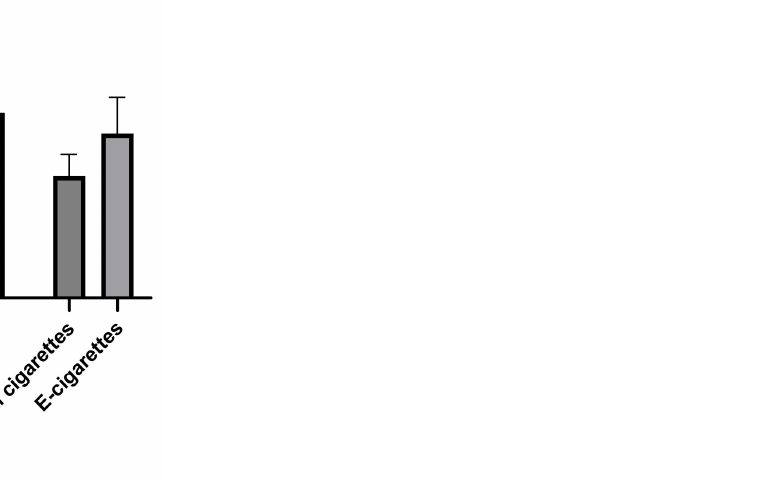
Figure 3. Concentration of xanthine in groups of e-cigarettes users, traditional cigarettes smokers and